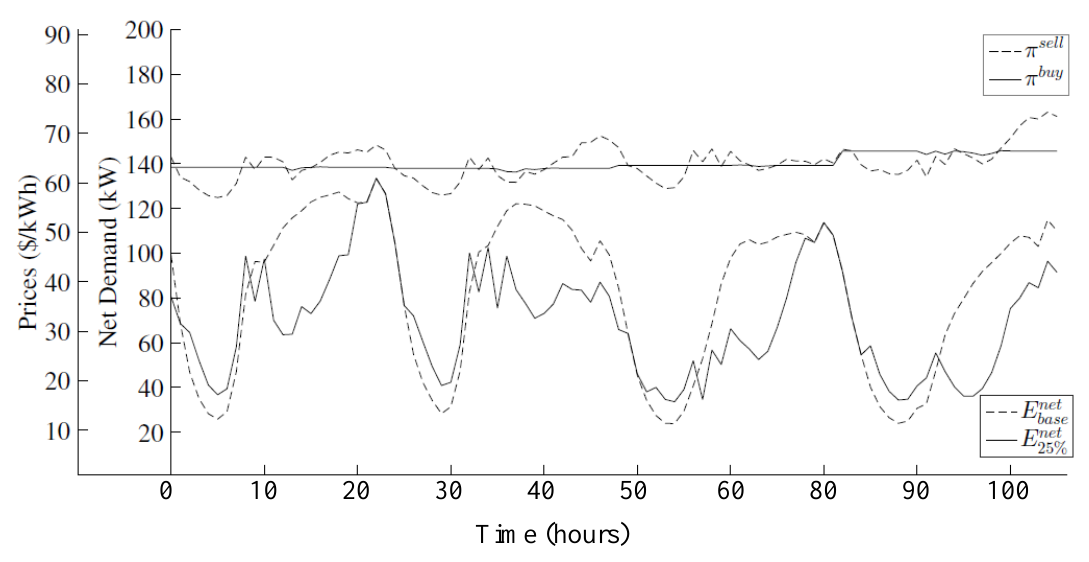
Figure 17. Prices and Net Demand for a 100-h Period with 25% of active with